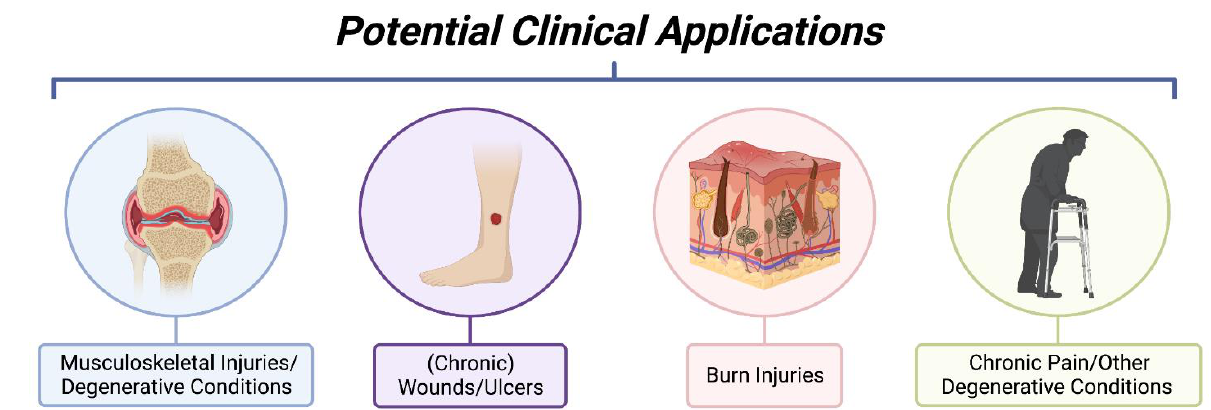
Figure 4. Summary of Potential Clinical Applications of Cell-Free Amniotic Fluid. Investigative clinical studies using cell-free amniotic fluid have been applied to musculoskeletal injuries such as those involving synovial joints, wound healing of chronic pressure ulcers, burn injuries to promote tissue regeneration, and in settings of chronic pain. The mentioned clinical applications are not exhaustive and only represent current applications under investigative study with published results. (Image created with Bio Render). Table 1. Summary of Completed Clinical Trials using AF or AF-derived interventions.